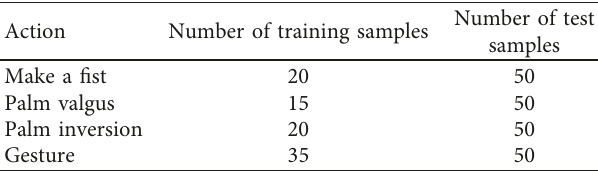
Table 3: Groups of surface EMG signals under normal